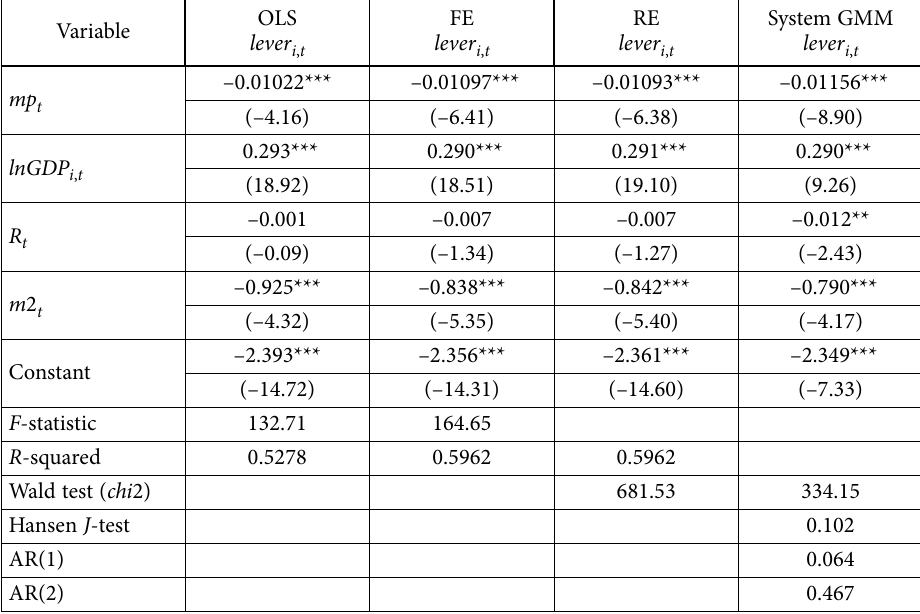
Table 6. The impact of macroprudential policies on credit Table 5. The impact of macroprudential policies on the real estate market